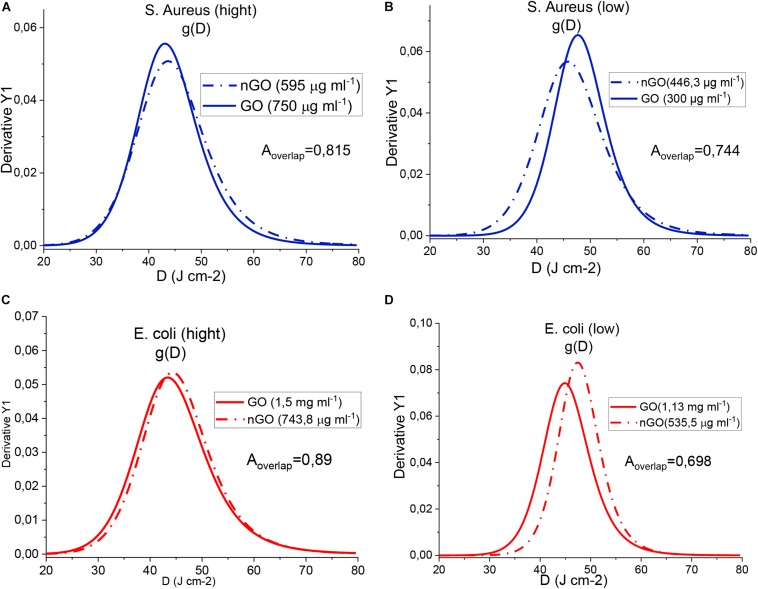
Area of overlap between the threshold dose distributions of the systems. (A)
S. aureus (high). (B)
S. aureus (low). (C)
E. coli (high). (D)
E. coli (low).